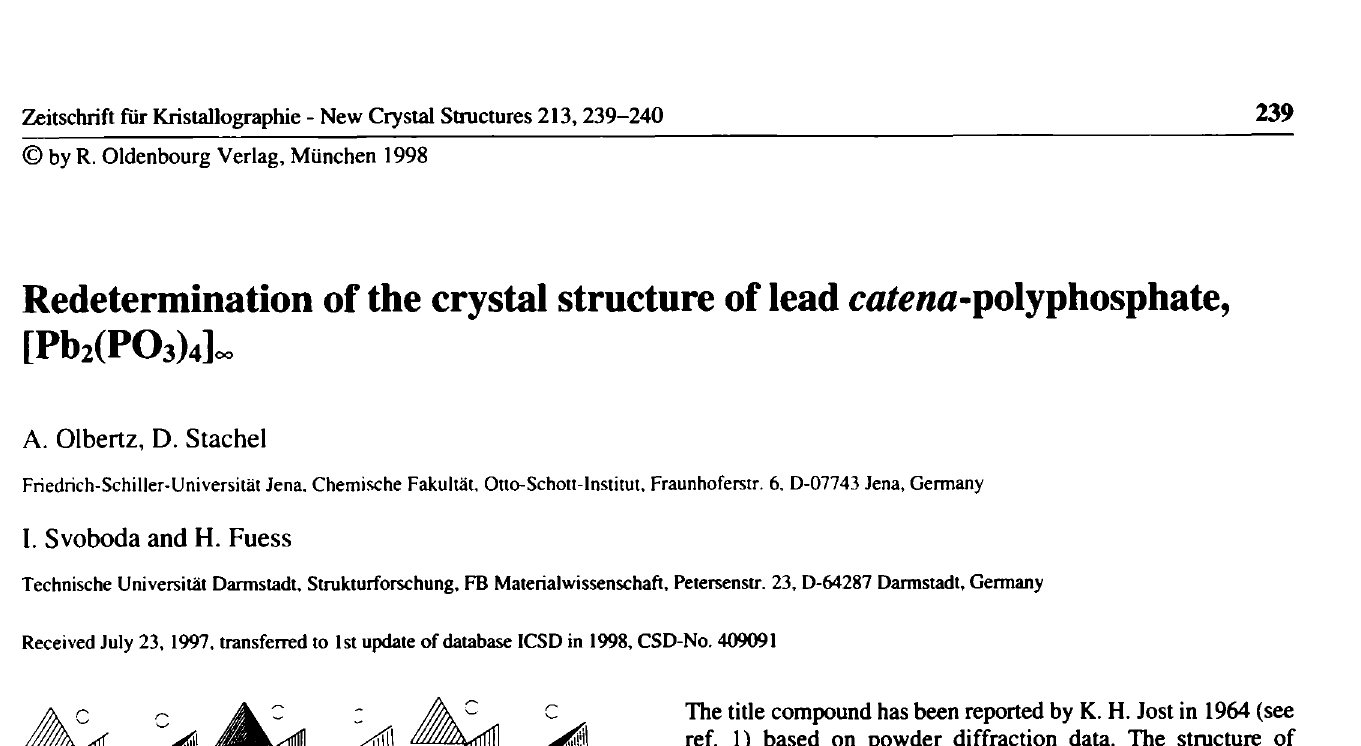
Table 1. Parameters used for the X-ray data collection